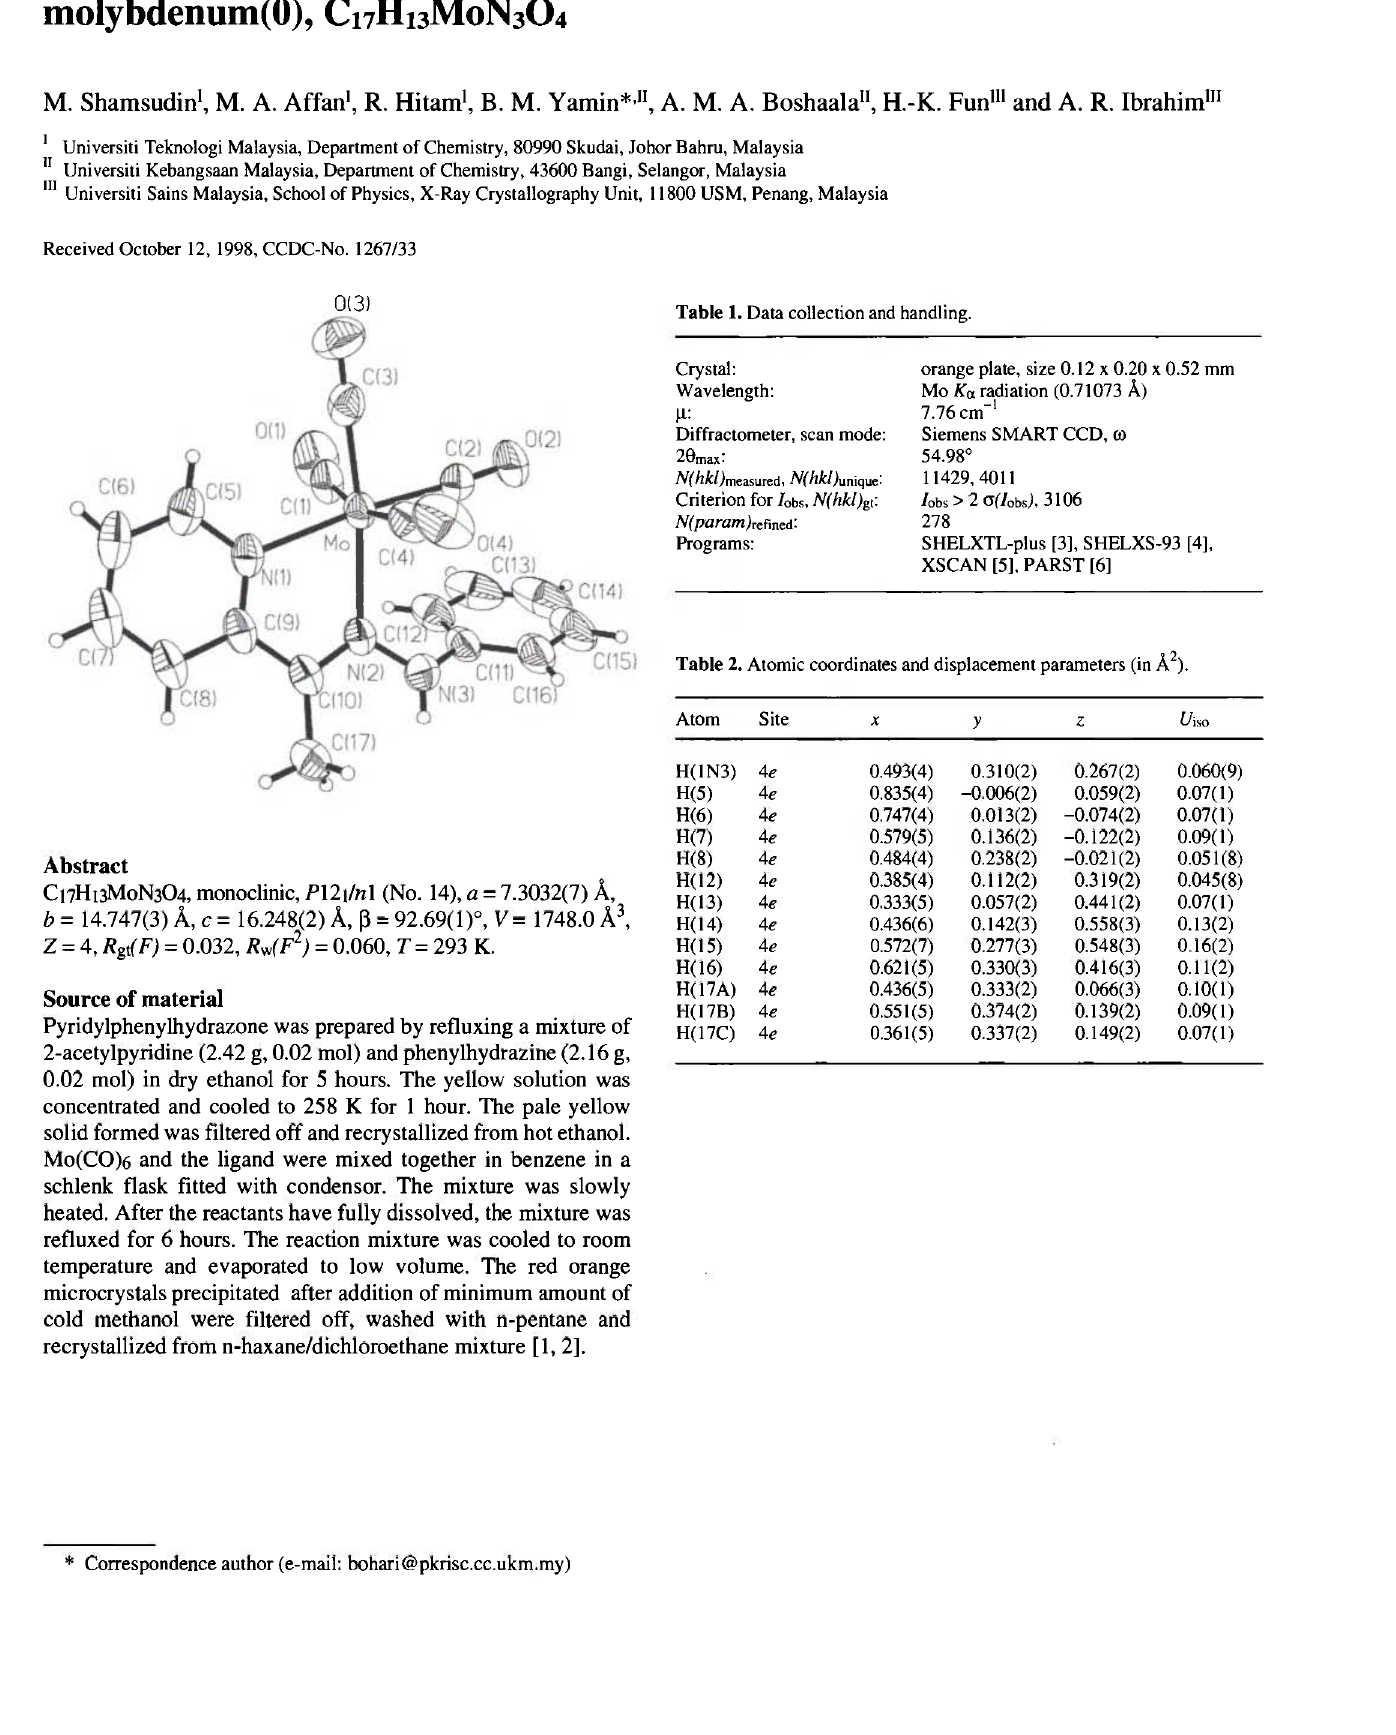
Table 1. Data collection and handling.